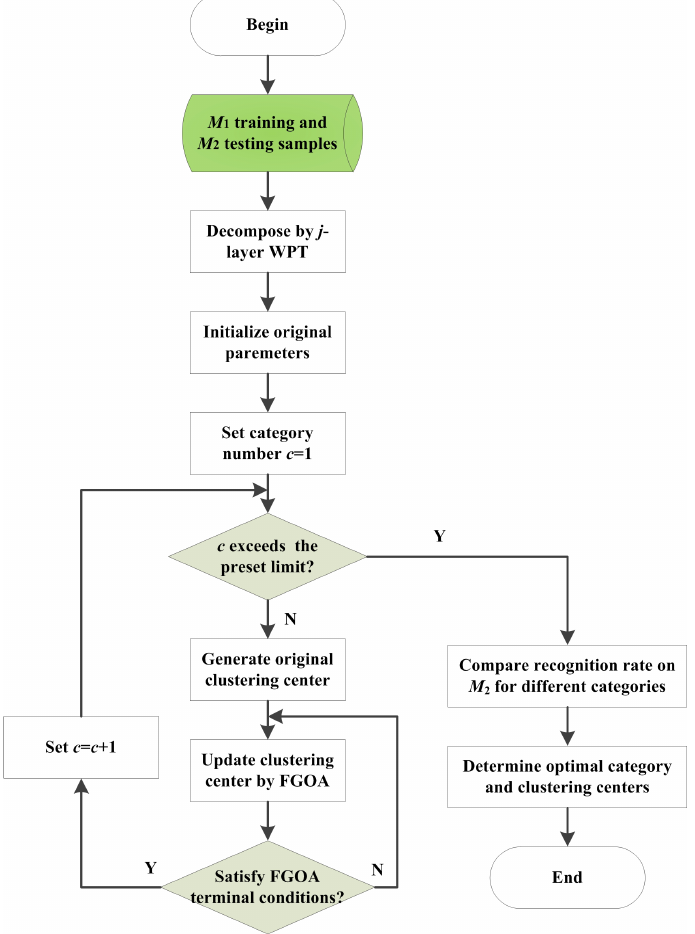
Figure 3. Flowchart of the fuzzy C ‐ means (FCM) ‐ FGOA. WPT, wavelet packet transform.